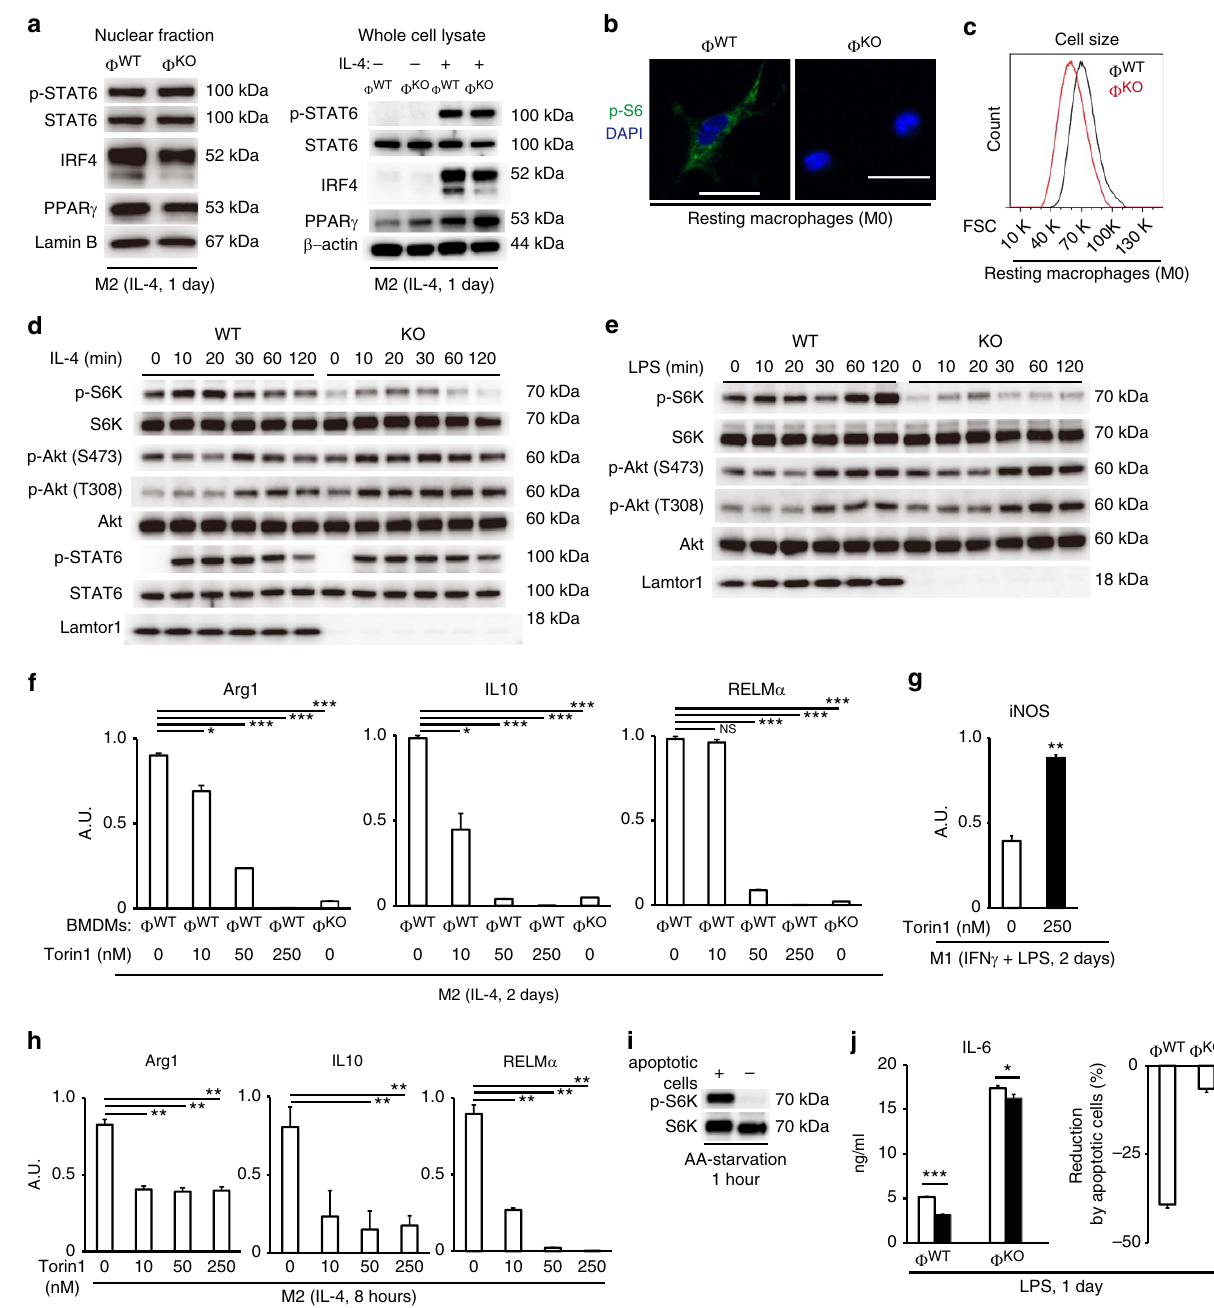
Figure 3 | Lamtor1 is required for IL-4 (cid:2) elicited activation of mTORC1, which is necessary for M2 polarization. ( a ) Western blots for previously known essential M2 (cid:2) polarizing factors in IL-4 (cid:2) stimulated BMDMs. See Supplementary Fig. 8a for confirmation of the fractionation. ( b ) Immunofluorescence confocal microscopy for phospho-S6 ribosomal protein indicated decreased mTORC1 activity in Lamtor1-deficient BMDM. Scale bars indicate 20 m